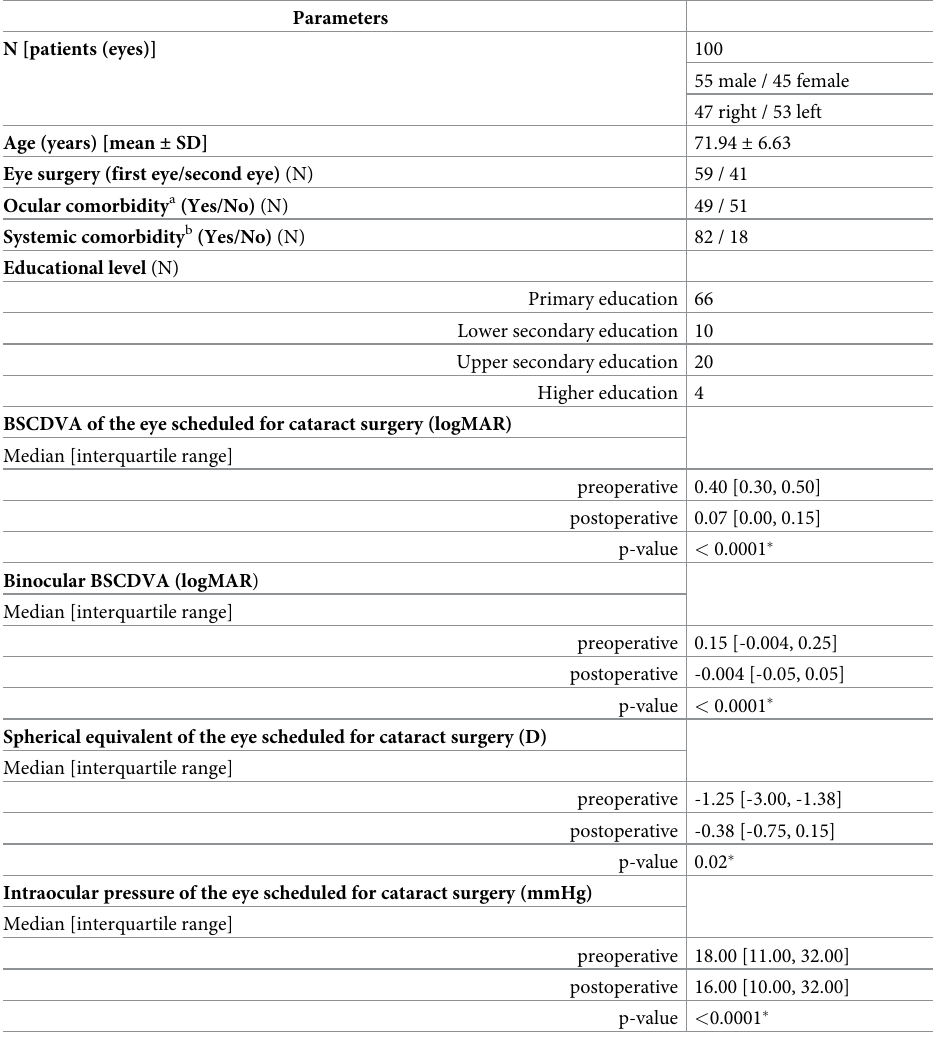
Table 1. Demographic characteristics. Pre- and postoperative clinical